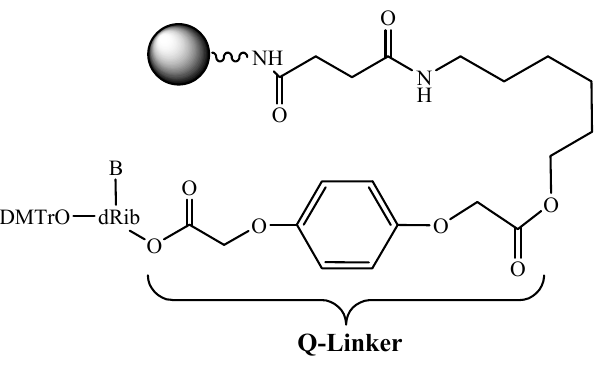
Figure 6. Reusable support for ODN